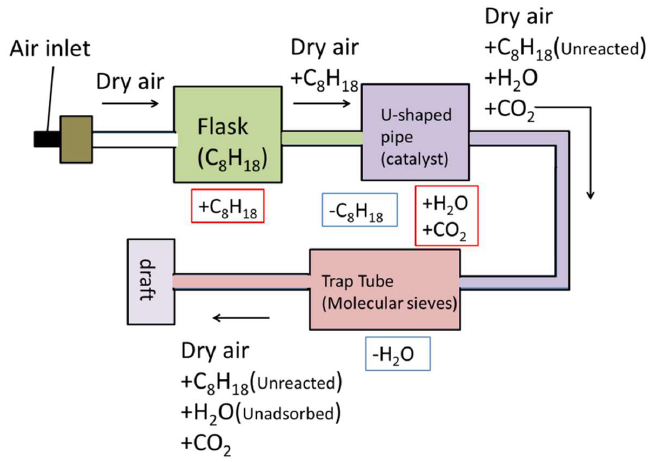
Figure 10. Schematic of the device used for evaluating the catalyst performance.